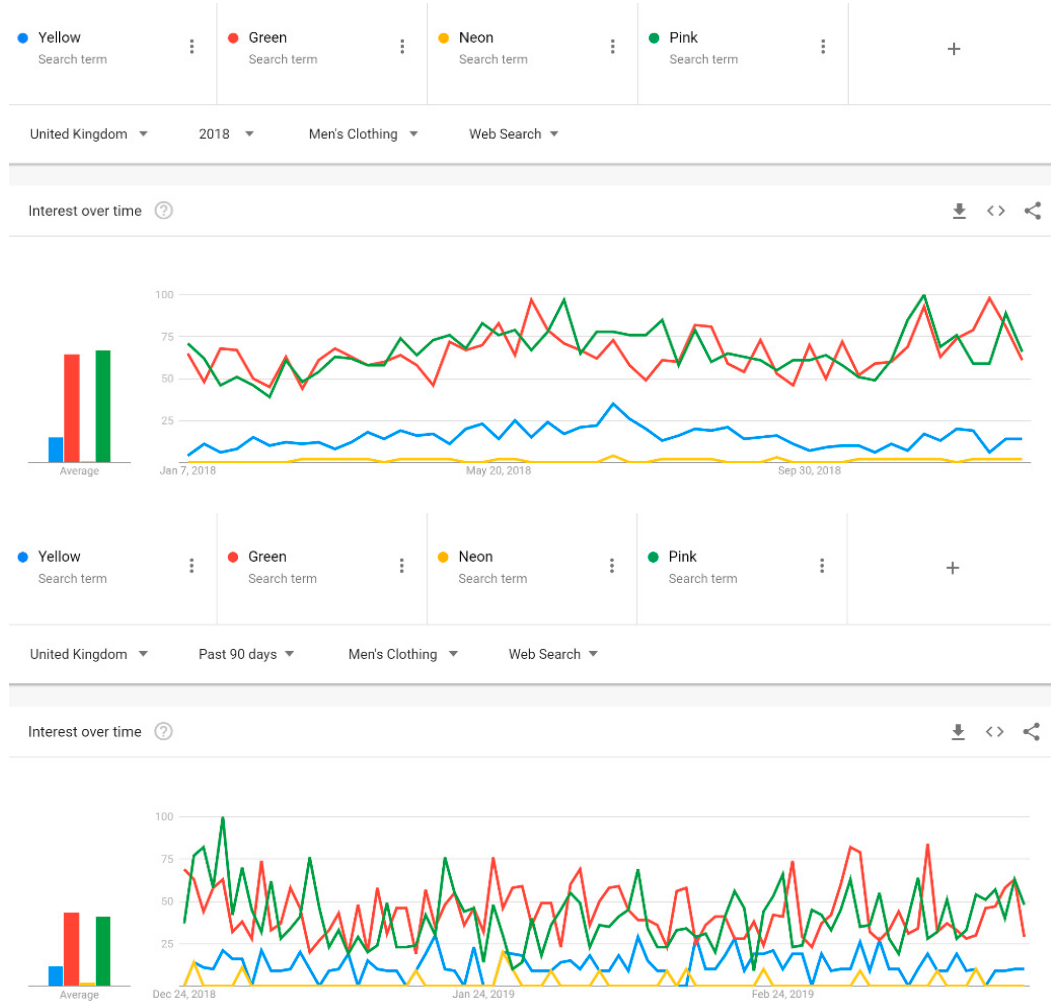
Figure 14. Time series plots for fashion consumer Google Trends on Edited’s 2019 trending colour ways for men’s clothing (Data Source: Google Trends, 24 March 2019).